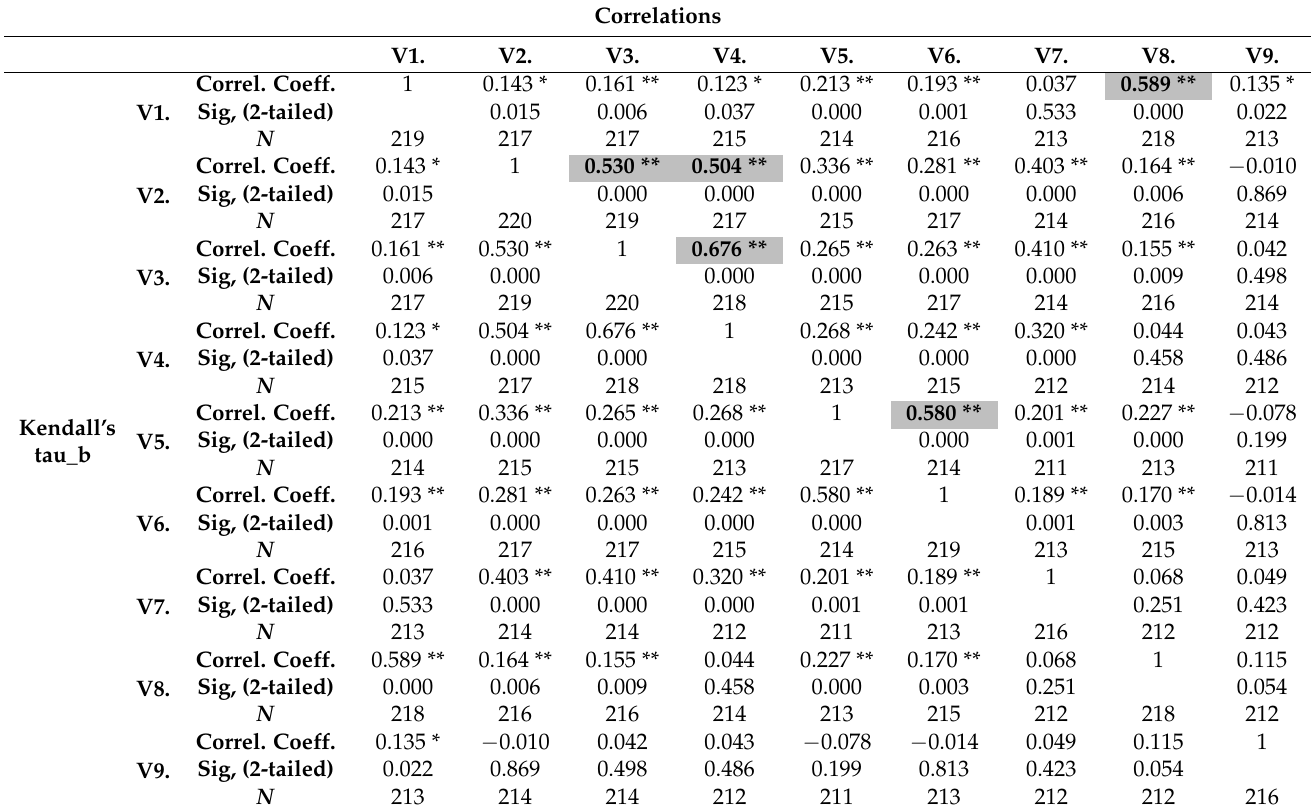
Table 7. Correlations between main factors which influence the participation of consumers in Demand Response programs, based on Kendall’s tau correlation